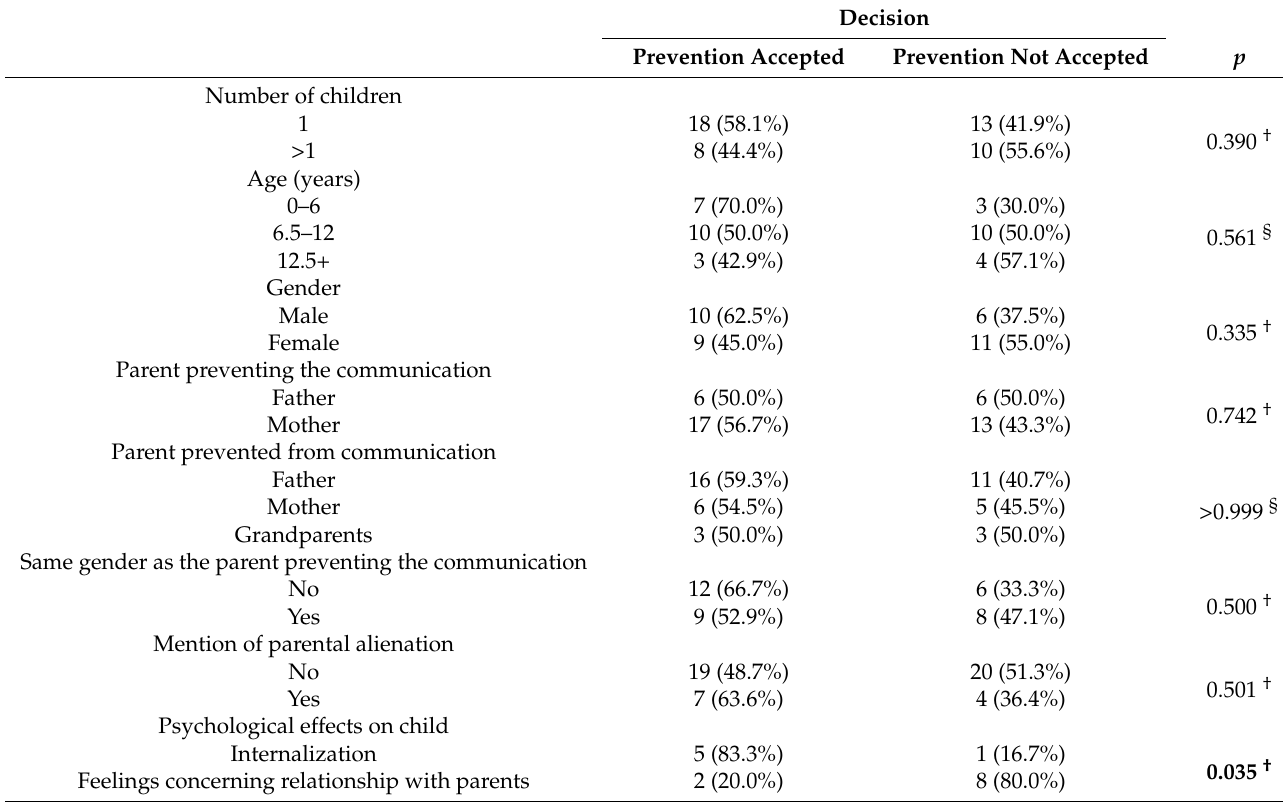
Table 2. Test of independence between jury’s decision and several demographic and other character-